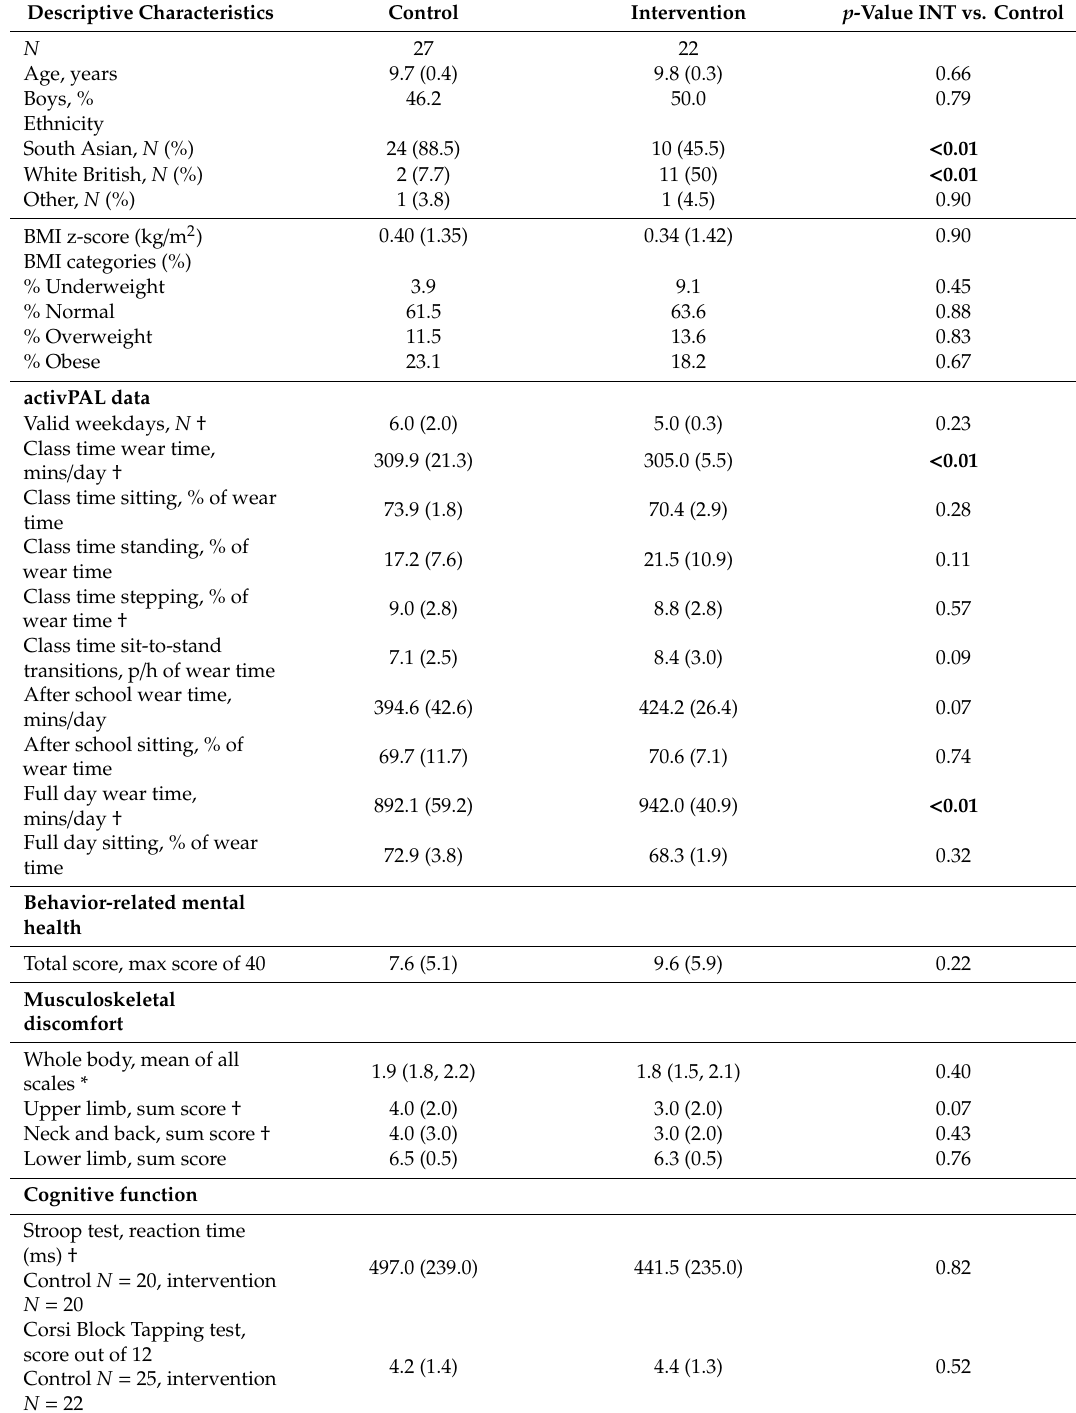
Table 1. Comparison of baseline characteristics between the control and intervention groups. Data presented as mean (SD) unless stated